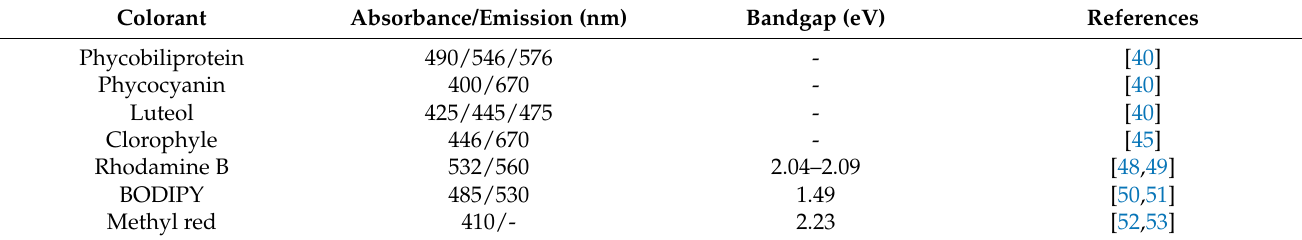
Table 2. Colorant optical